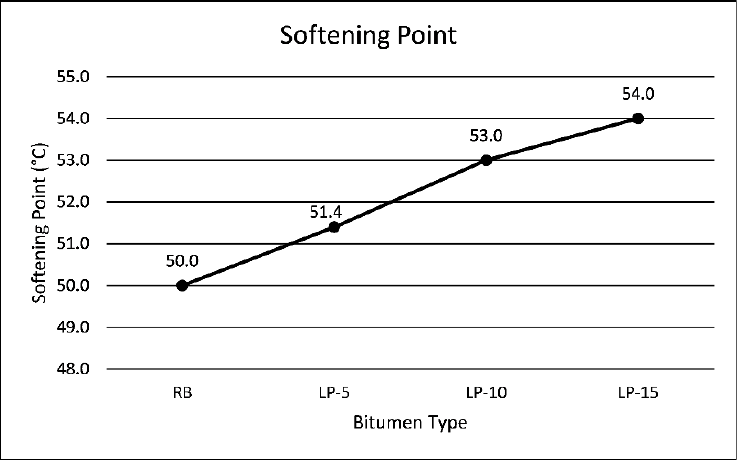
Figure 13. Change of softening point with respect to reference bitumen . 3.3. Elastic Recovery Test The elastic recovery test was carried out at 25 °C, with respect to EN 13398. The test was performed in order to detect potential significant change in the elastic recovery of the RB, with the addition of kraft lignin powder. The relevant results are given in Table 4. As it can be seen from Table 4, no significant change in the elastic recovery has been achieved with the addition of up to 15% of lignin powder. Table 4. Elastic recovery results. Bitumen/Blend